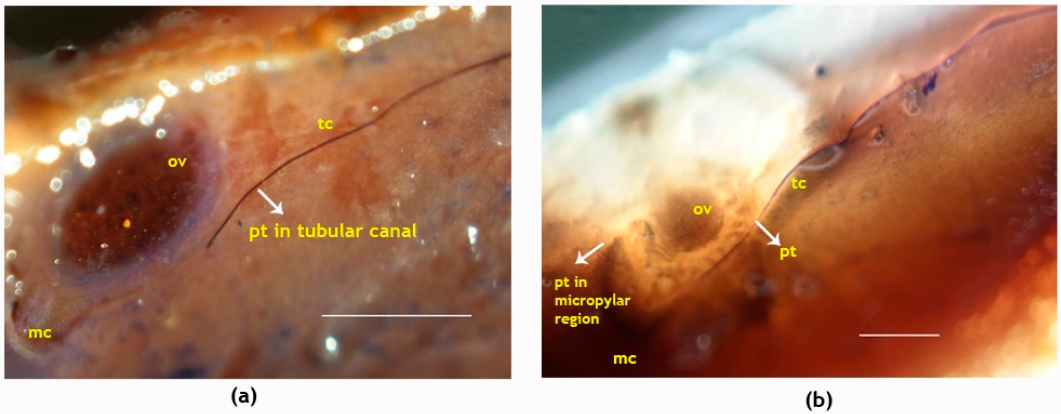
Figure 4. In planta pollen grain germination of the coconut variety WCT on the receptive stigma surface after pollination. ( a ) Ungerminated pollen grains 4 h after pollination and ( b ) germinated pollen grains with pollen tubes 24 h after pollination. Pollen tubes are marked by an arrow (pt); pg, pollen grains. Stigma surface was stained with quadruple stain [59] and visualized using a stereo microscope. Scale bar = 100 μ m.